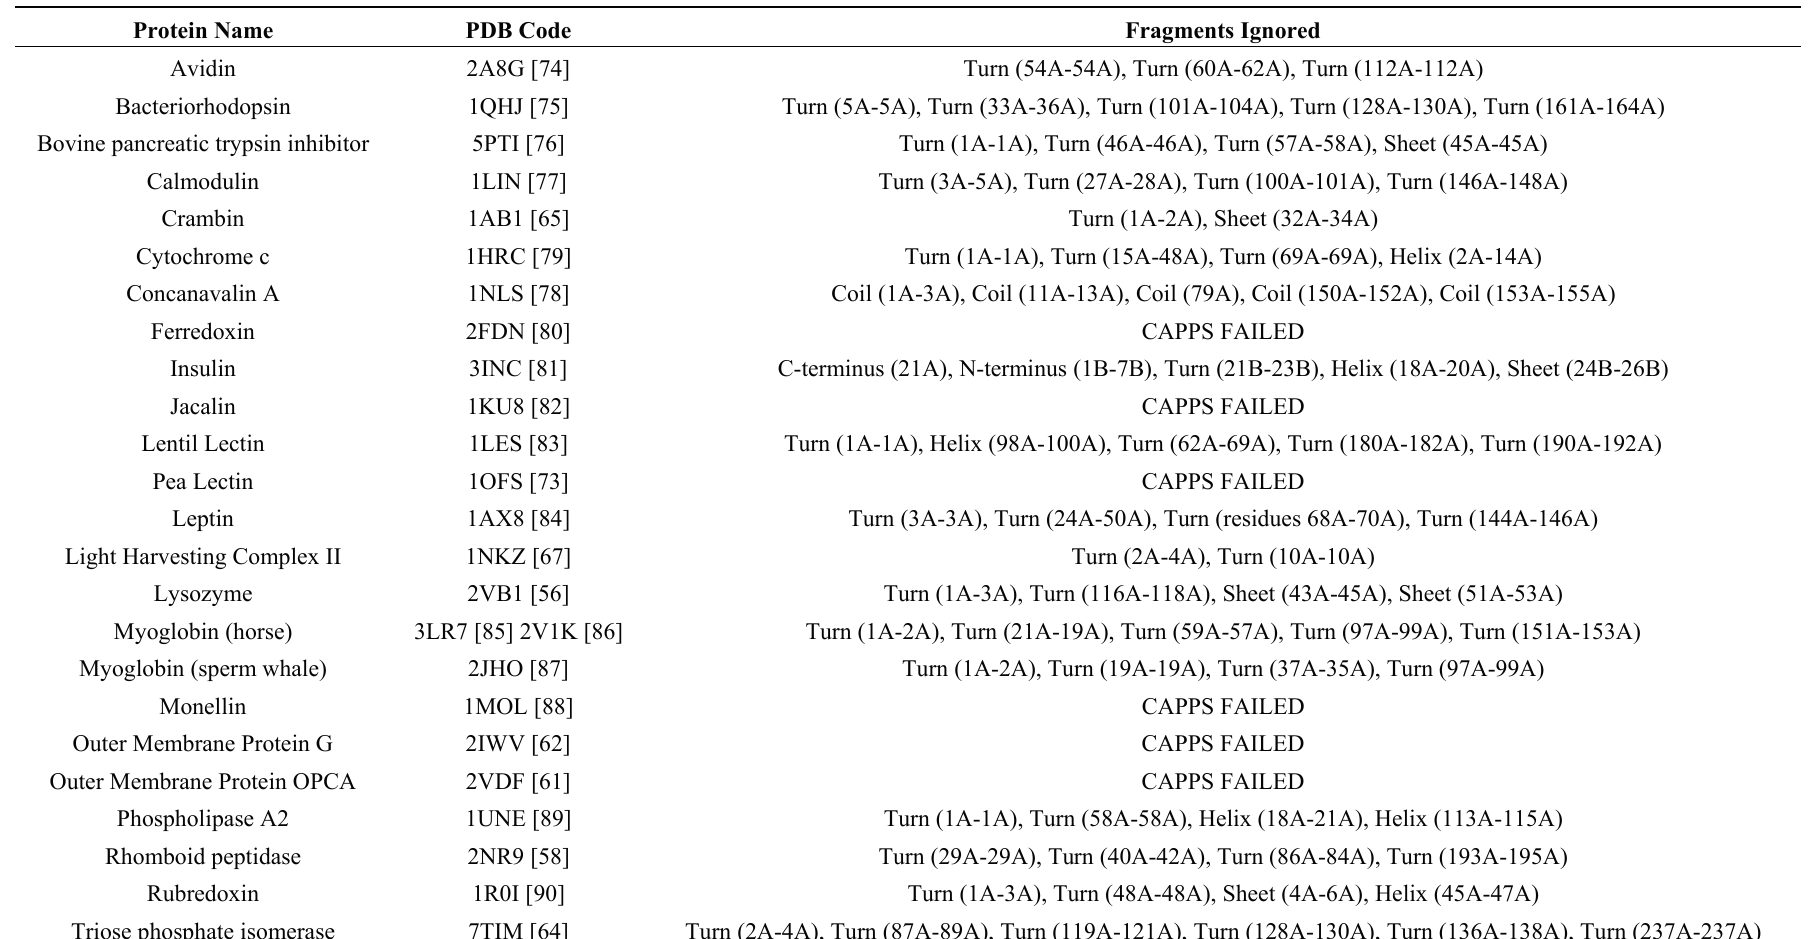
Table 7. PDB Structures Computed Using CAPPS and Fragments